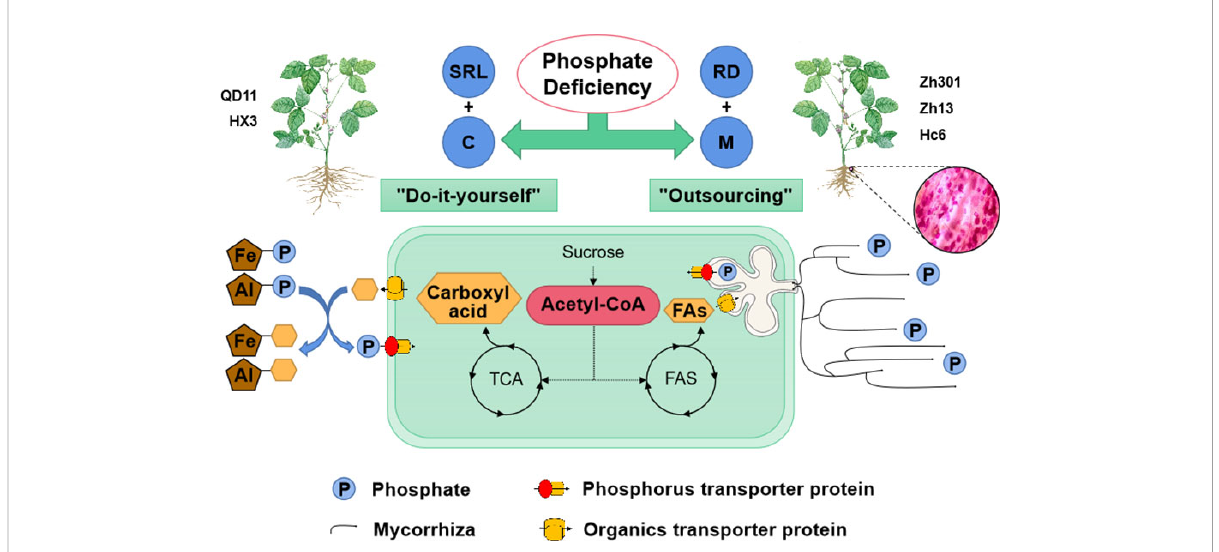
FIGURE 6 Schematic representation of phosphorus acquisition strategies in soybean under phosphate de fi ciency. Under low phosphorus availability, two types of phosphorus acquisition strategies —” do-it-yourself ” and “ outsourcing ” were used by soybean varieties. The “ do-it-yourself ” varieties obtained suf fi cient phosphorus by increasing their SRL and secreting carboxylic acids (SRL+C). By secreting carboxylic acids, roots dissolve phosphorus immobilized by iron and aluminum, which elevates the concentration of phosphorus in soil water. Additionally, the “ do-it-yourself ” varieties had larger SRLs, indicating a larger root surface area, which further promoted phosphorus absorption. Owing to their larger root diameters, the “ outsourcing ” varieties utilized increased symbiosis with mycorrhizal fungi to obtain phosphorus (RD + M). The direction of acetyl-CoA metabolism might be the dividing line between the “ outsourcing ” and “ do-it-yourself ” strategies of soybean. The “ do-it-yourself ” varieties converted acetyl-CoA into carboxylic acid, primarily through the TCA cycle, whereas the “ outsourcing ” variety converted it into fatty acids, which were used to exchange phosphorus with mycorrhizal fungi. SRL, speci fi c root length; RD, average diameter of roots; M, Mycorrhizal fungi; C, Carboxyl acid; FAs, Fatty acids; TCA, Tricarboxylic Acid Cycle; FAS, Fatty Acid